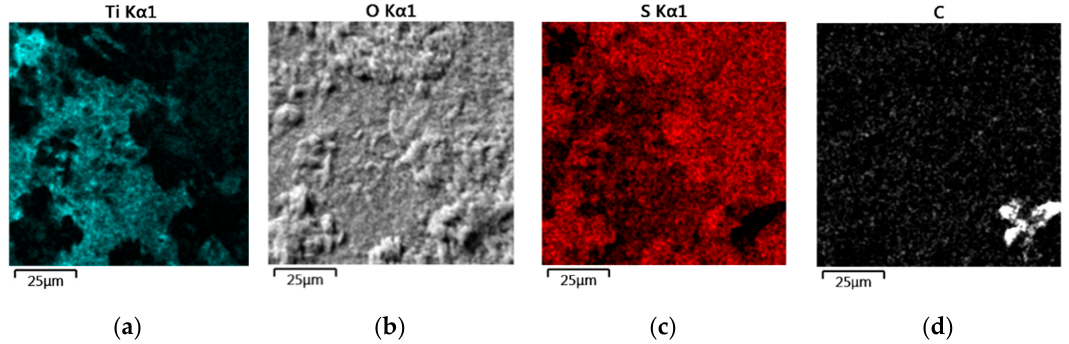
Figure 6. Legend of mapping the chemical elements Ti ( a ), O ( b ), S ( c ), and C ( d ) of a modified fraction of titanium hydride under dynamic conditions in the presence of NH 4 OH (pH = 4–5).